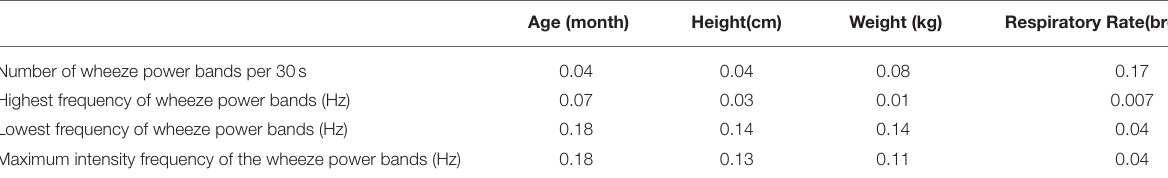
TABLE 2 | P -values of correlations of the wheezing indexes with age, height, and weight.